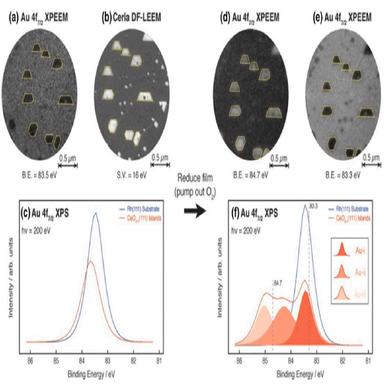
XPEEM/LEEM and local XPS of Au on CeO1.67 (111)/Rh (111): (a) Energy-filtered XPEEM (B. E. 83.5 eV). (b) Dark-field LEEM. (c) Au 4f7/2 XPS derived from energy-filtered XPEEM. (d) Energy-filtered XPEEM (B. E. of 84.7 eV). (e) Energy-filtered XPEEM (B. E. of 83.3 eV). (f) Au 4f7/2 XPS derived from energy-filtered XPEEM.